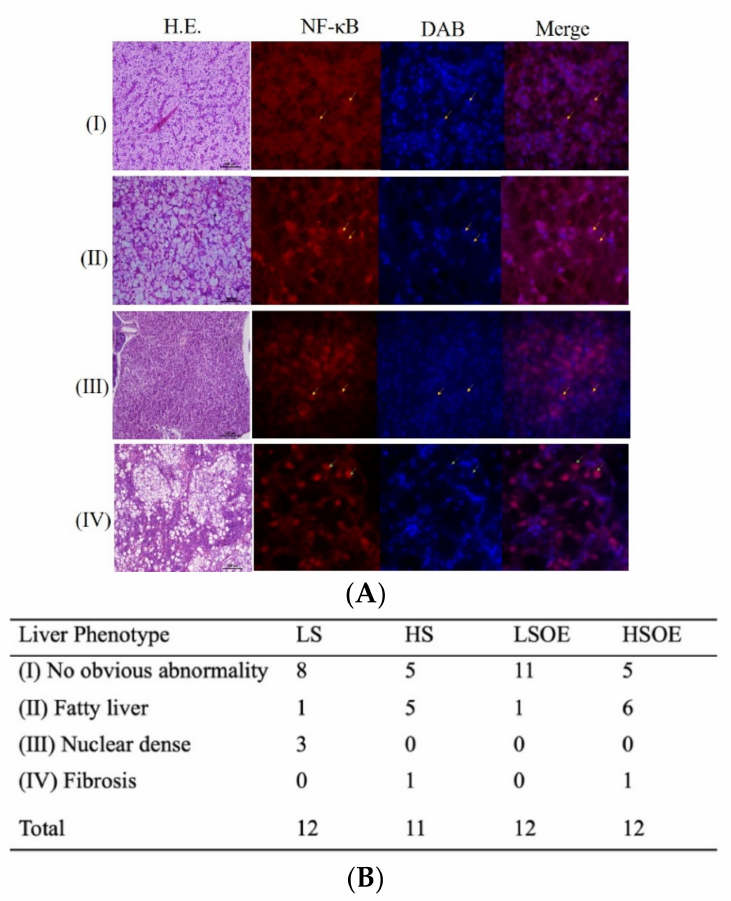
Figure 1. Effects of different diets on hepatic histopathological and inflammatory responses of largemouth bass. ( A ) Four phenotypes of hepatic histopathological examination with symptoms from light to heavy by HE staining for histology examination. Inflammatory response signals of NF- κ B were lower (marked by yellow arrows) and mainly (marked by green arrows) expressed in the nucleus (marked with DAPI in blue color) (bar = 15 µ m), in which (I) no obvious abnormity, (II) fatty liver, (III) nuclear dense tissue, and (IV) hepatic fibrosis symptoms were observed. ( B ) Statistical results of liver phenotypes (n = 12). Since the samples were damaged during the embedding process, the number of slices was less than 12 of the HS